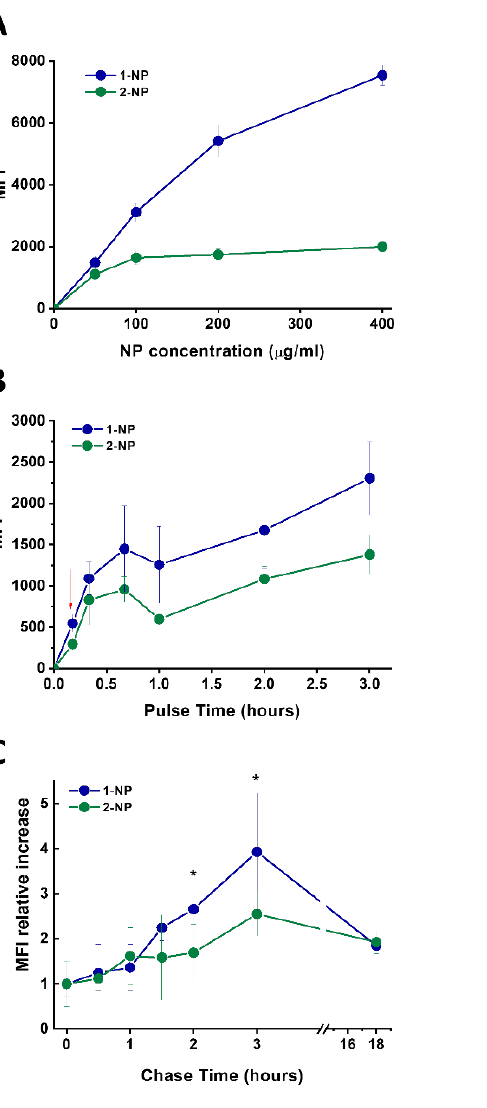
Figure 3. Capture, intracellular disassembly and antioxidative efficacies of F127@ 1 -NP and F127@ 2 -NP in t-BHP-treated human macrophages. ( A ) Cells were incubated with the indicated doses of fluorescently labeled F127@ 1 -NP and F127@ 2 -NP, for 3 h in DMEM plus 10% FCS and analyzed, after washing in NP-free medium, by flow cytofluorimetry. Data (Mean Fluorescence Intensity) are the mean of 4 independent experiments ± SE. ( B ) Cells were incubated with F127@ 1 -NP and F127@ 2 -NP (100 µg/mL) for the indicated time lapses and analyzed for their MFI by flow cytofluorimetry as above (data are mean ± SE, N = 4). The red arrow indicates the pulse – chase experiments described in panel ( C ). Cells were pulsed for 10 min as in panel ( B ), washed 3 times with PBS and further cashed in cell medium with no NPs for the indicated times. MFI acquired by flow cytometry after cell recovery are expressed as relative values compared to the MFI one after the pulse time (taken as 1). Data are mean ± SE (N = 3). * Significance t < 0.05 of the difference between F127@ 2 -NP and